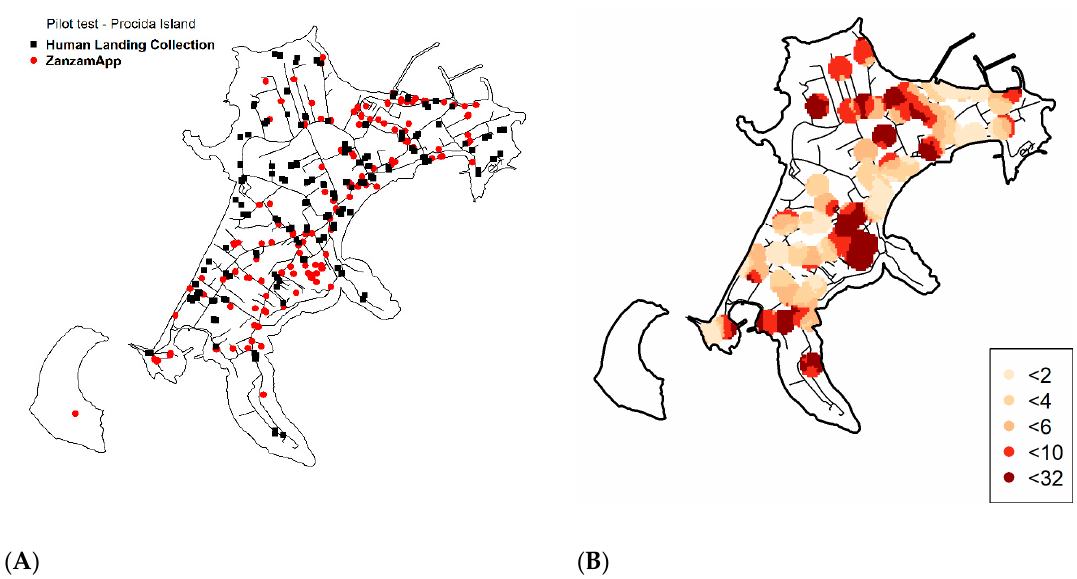
Figure 5. Procida Island (Gulf of Naples, Italy). ( A ) Location of ZanzaMapp records (red circles) and Human Landing Collections (HLC; black squares) in September 2016. ( B ) Aedes albopictus abundance estimate based on ZanzaMapp records. Black lines represent roads.